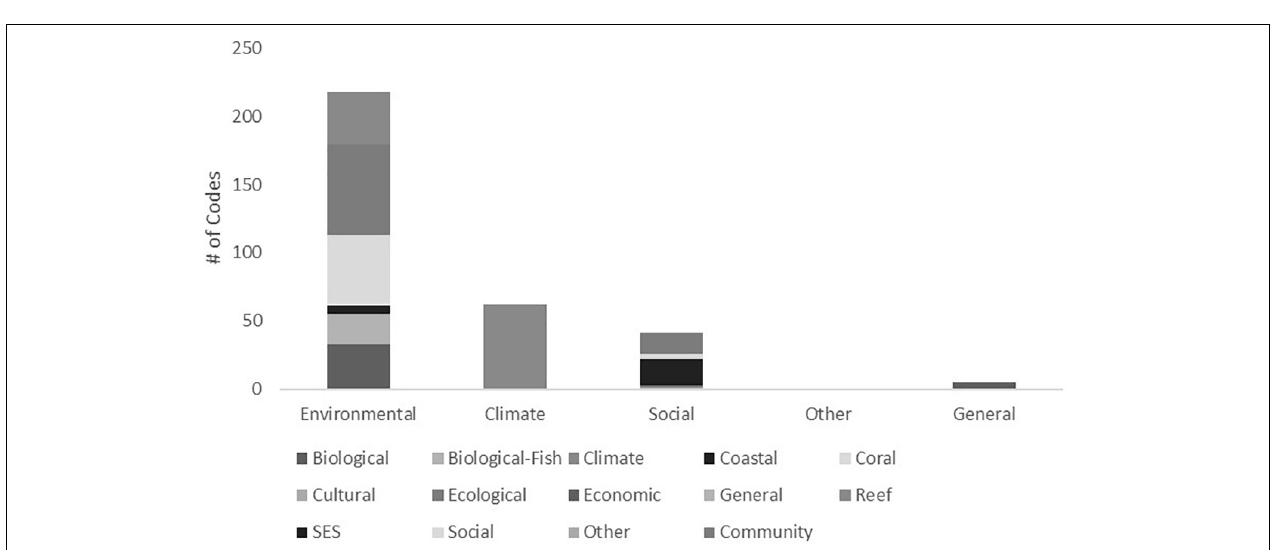
FIGURE 6 | Resilience codes by entity. The panel shows both the number of references made by each entity and the breakdown of what type of resiliency each entity made. See Table 3 for resiliency definitions. N = 132. Data collected from https://oceanconference.un.org/commitments/ as of September 2017.